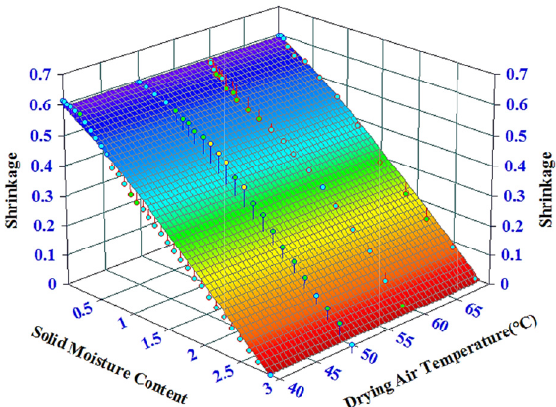
Fig. 10. Variation of hawthorn shrinkage versus solid moisture content at different drying air temperatures (drying air flow rate=26 m 3 /h and vibration intensity=7.5